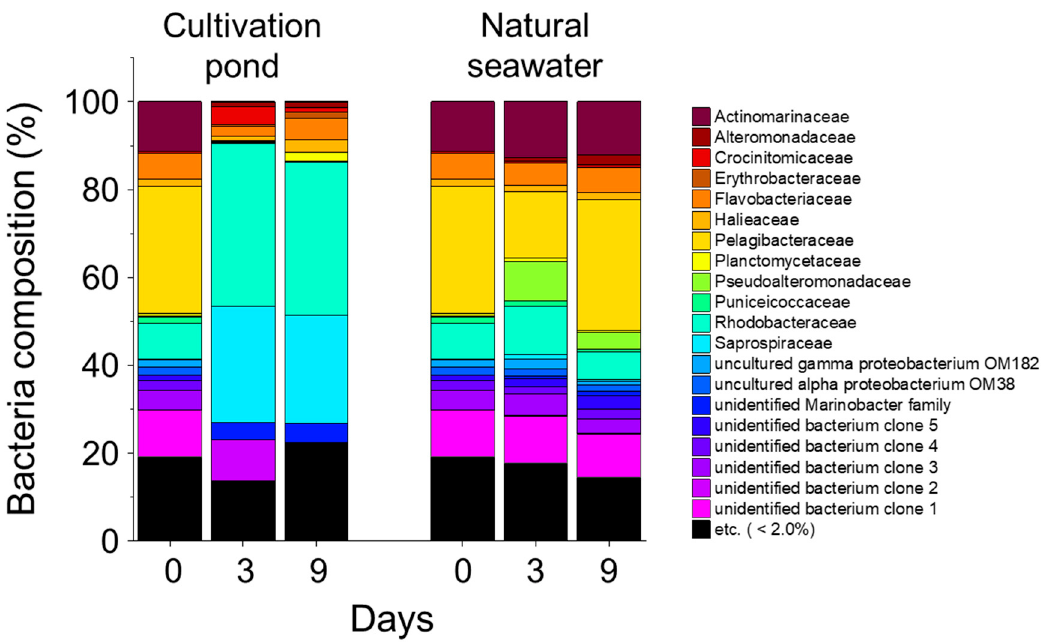
Figure 4. Changes in bacterial composition in cultivation pond and near (3 m away) seawater for nine days.